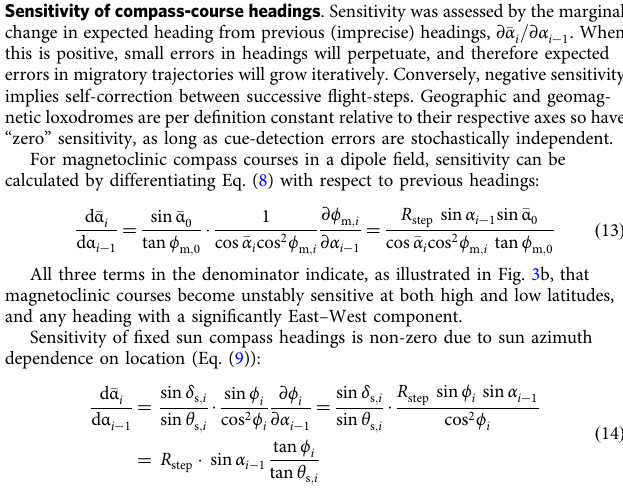
The sine factor on the right-hand side in Eq. (14) causes the sign of ∂ (cid:1) α i = ∂ α i (cid:2) 1 to be opposite for East to West or West to East headings, and tan θ s also change sign